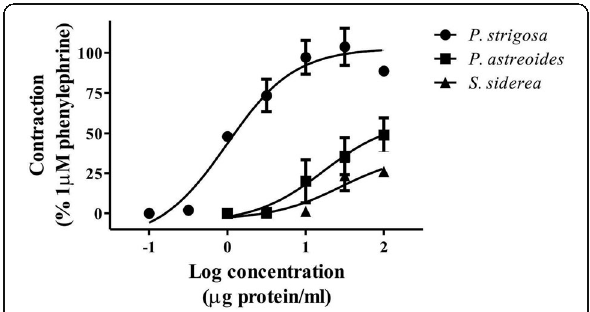
Fig. 3 Log-concentration response curves showing the vasoconstrictor activity of the extracts